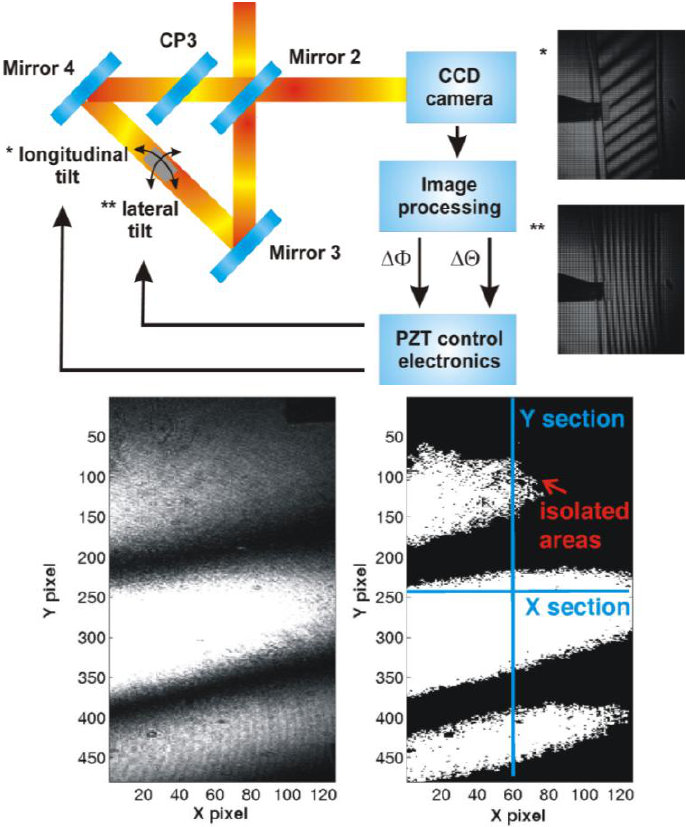
Figure 5. An example of the longitudinal (*) and lateral (**) tilt of the gauge block is shown on the right-hand side of the picture. At the bottom part, there is an example of the recorded image before (left) and after (right) applying of the flooding technique. The picture shows below an example of taking the X and Y sections to identify the number of interference fringes and their